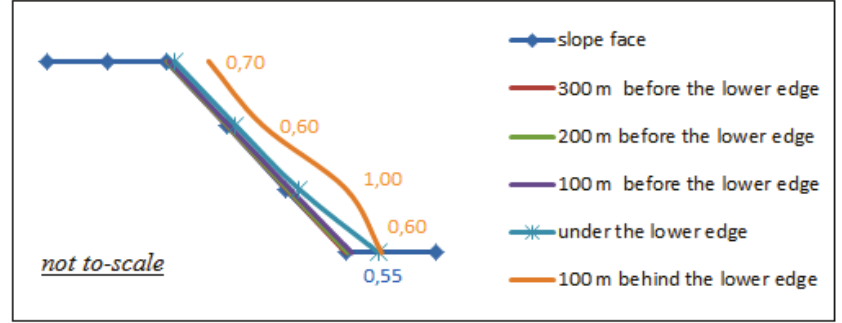
Fig. 18. Horizontal displacement of slope face when the longwall operation proceeds from the right side toward the lower edge of slope (measured point is the face of the longwall